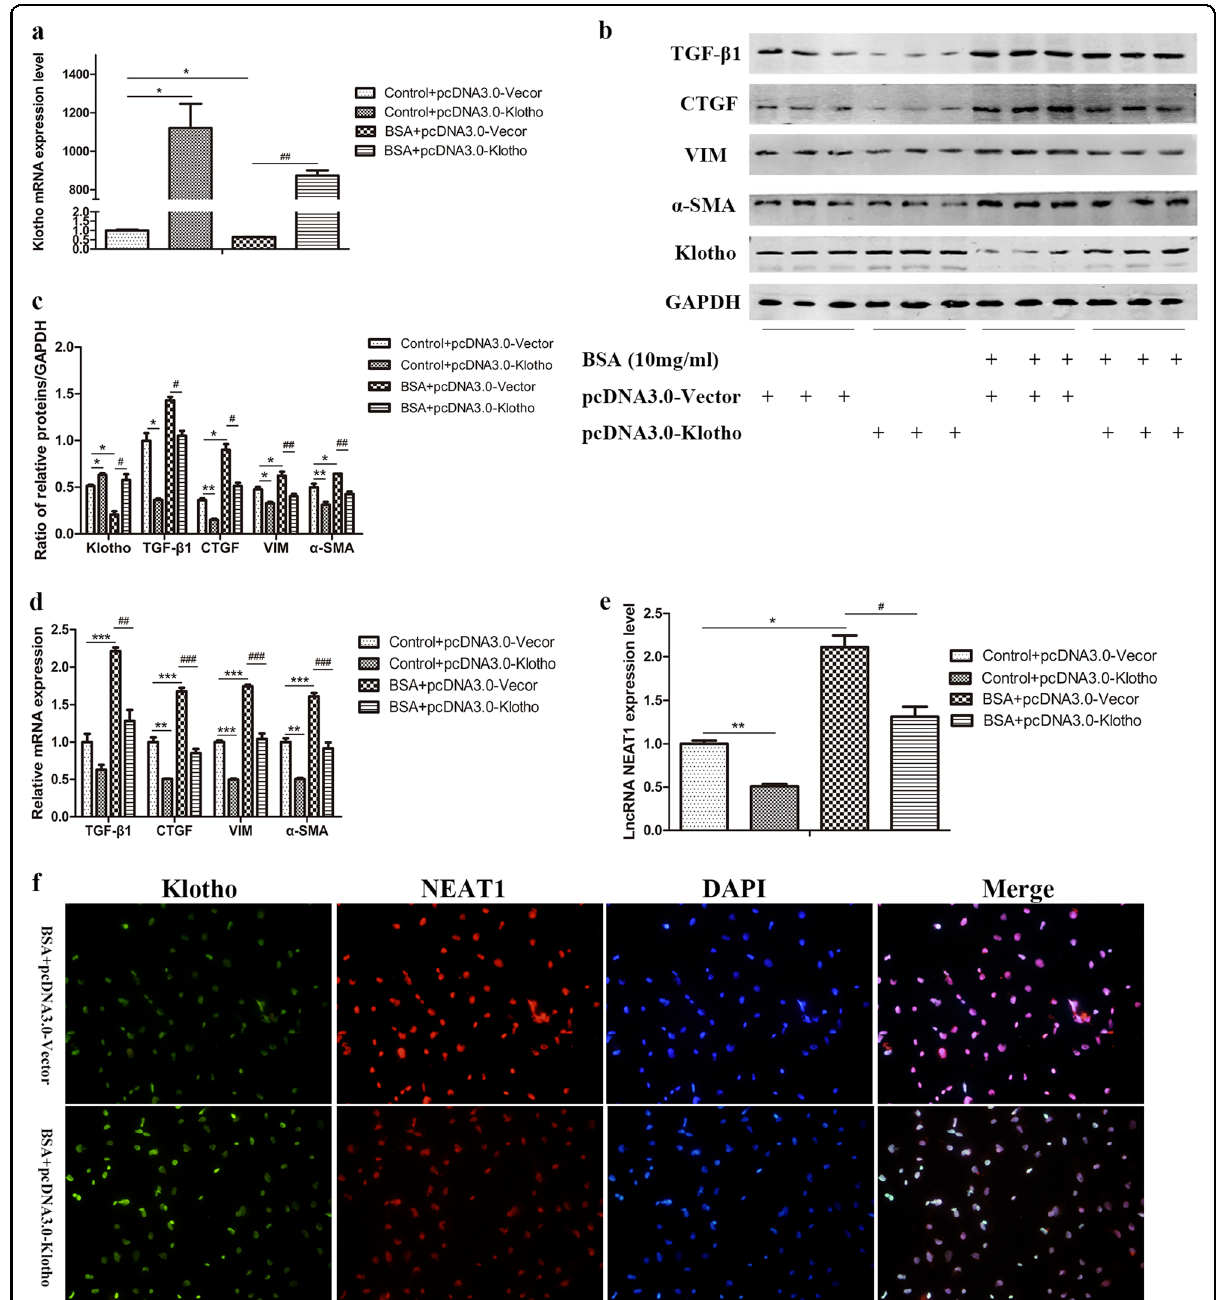
Fig. 6 Overexpression of Klotho suppressed NEAT1 expression in BSA-induced HK-2 cells. HK-2 cells were transfected with pcDNA3.0-Klotho and treated with 10 mg/ml BSA for 48 h. a Expression of Klotho mRNA was measured by qRT-PCR. b , c The protein levels of TGF- β 1, CTGF, vimentin, α -SMA, and Klotho were measured by western blots. d , e The mRNA levels of TGF- β 1, CTGF, vimentin, α -SMA, and lncRNA NEAT1 were measured by qRT-PCR. f Immuno fl uorescence and FISH were performed to investigate the expression and location of Klotho and NEAT1 after transfection with pcDNA3.0-Klotho in BSA-treated HK-2 cells. * p < 0.05 vs control + pcDNA3.0-vector, ** p < 0.01 vs control + pcDNA3.0-vector, *** p < 0.001 vs pcDNA3.0-vector; # p < 0.05 vs BSA + pcDNA3.0-vector, ## p < 0.01 vs BSA + pcDNA3.0-vector, ### p < 0.001 vs BSA +